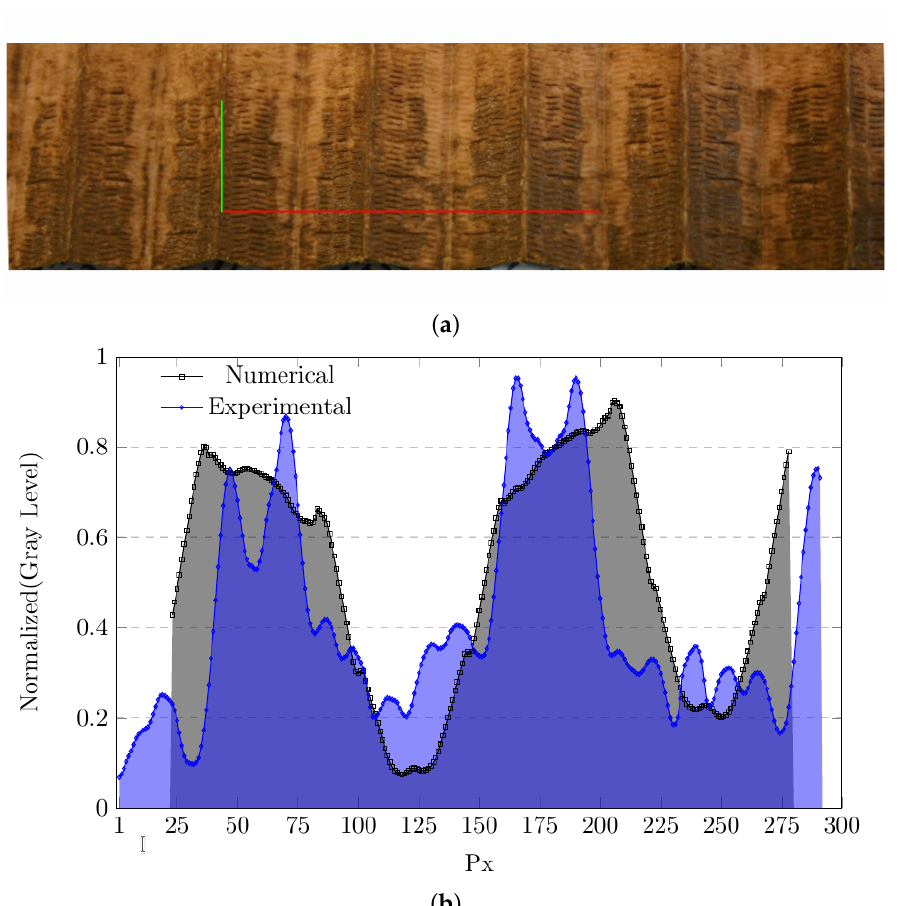
Figure 8. Intensity profile: ( a ) averaging zone; ( b ) comparison. Notice the effect of the pleats that are in contact with the upper side of the real device, which yields a double-peaked